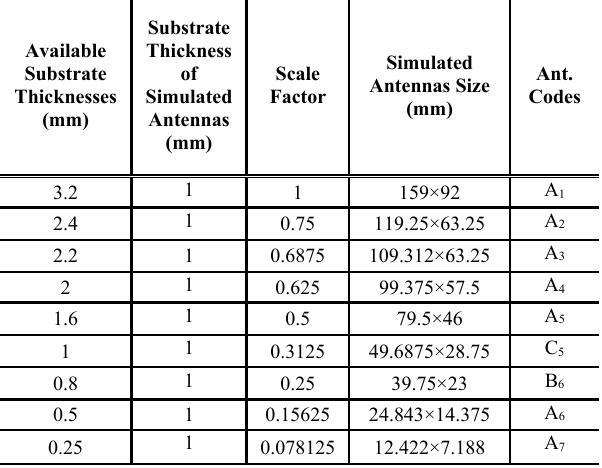
Table 1. The scale-factor and dimensional scaling properties of simulated antennas.